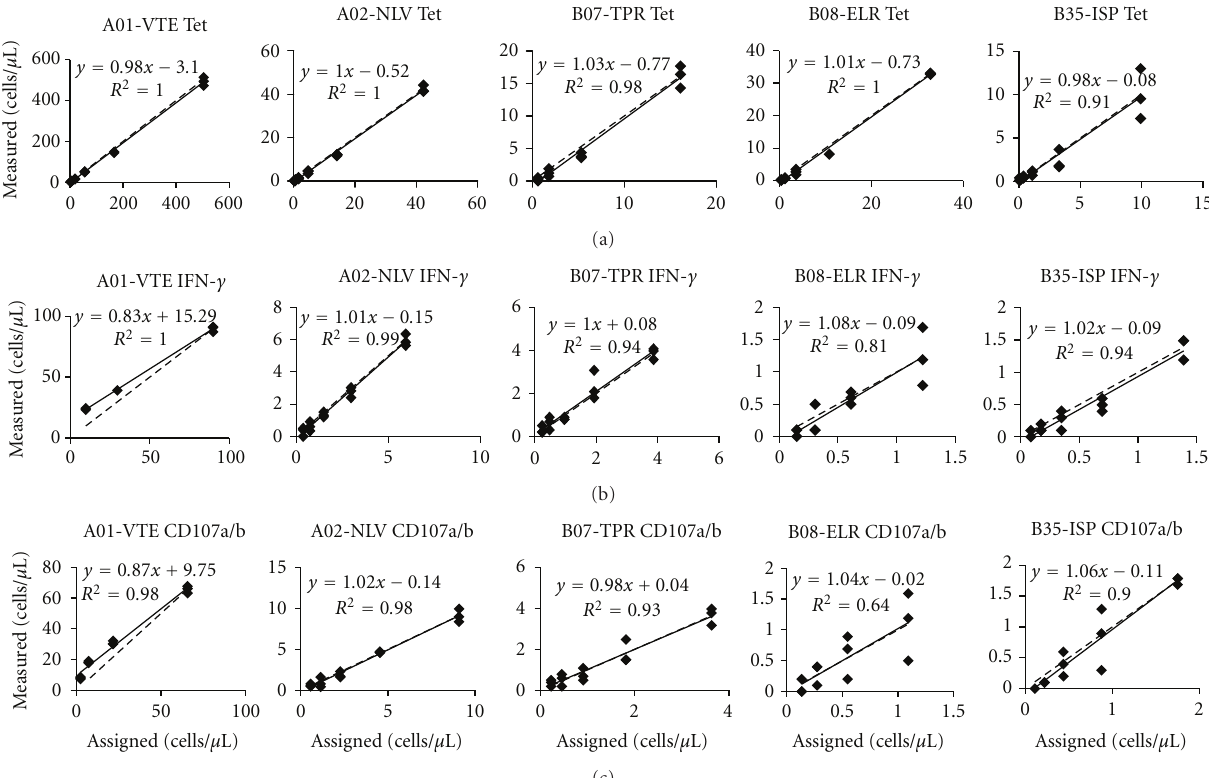
Figure 1: Linearity of tetramer staining and peptide-stimulation assays. Panel A shows the scatter plots of tetramer staining with five allele- specific tetramer reagents. Panel B represents data for peptide-stimulation assay that measures INF- γ production. Panel C corresponds to CD107a/b expression after stimulation with allele-specific peptides.